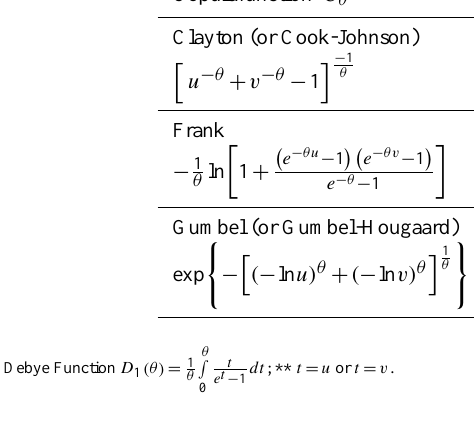
Table 1 contains an overview of the Copula functions